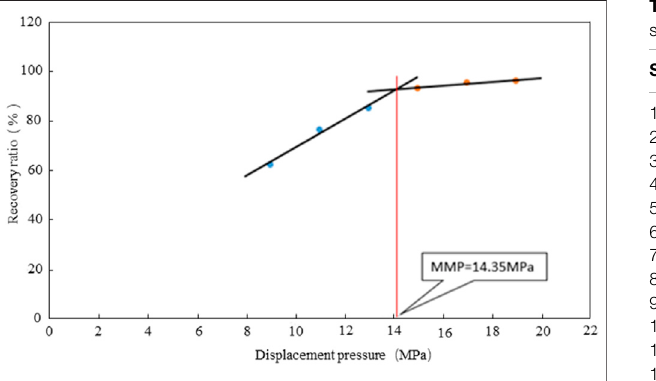
FIGURE 4 | The relationship between the CO 2 displacement recovery ratio and displacement pressure in the slim tube test of sample 1.